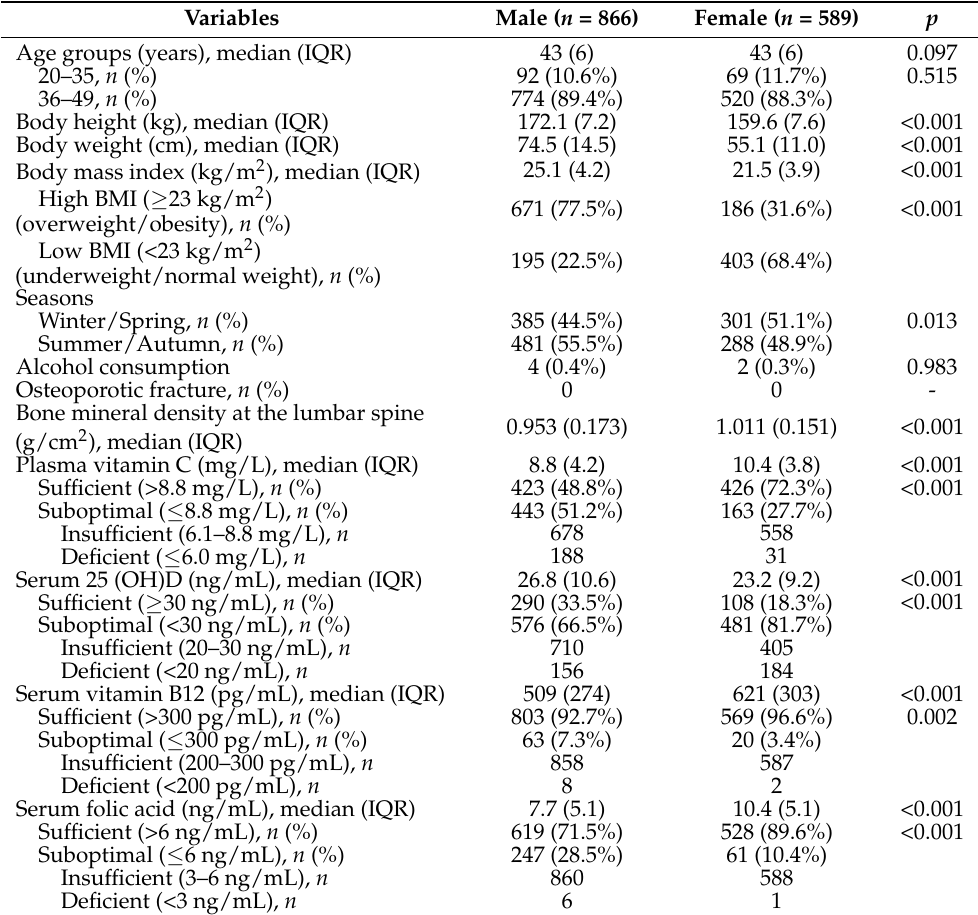
Table 1. Demographic/anthropometric characteristics and laboratory and radiology results of the study